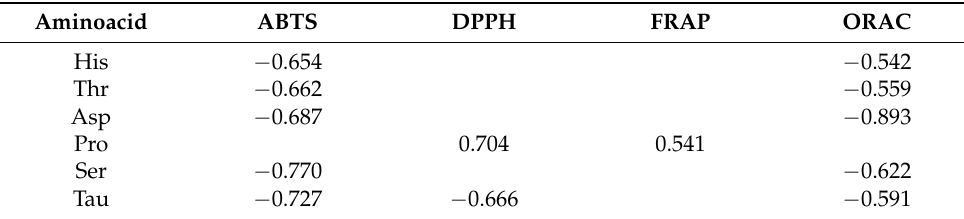
Table 2. Correlations between free amino acids and in vitro antioxidant